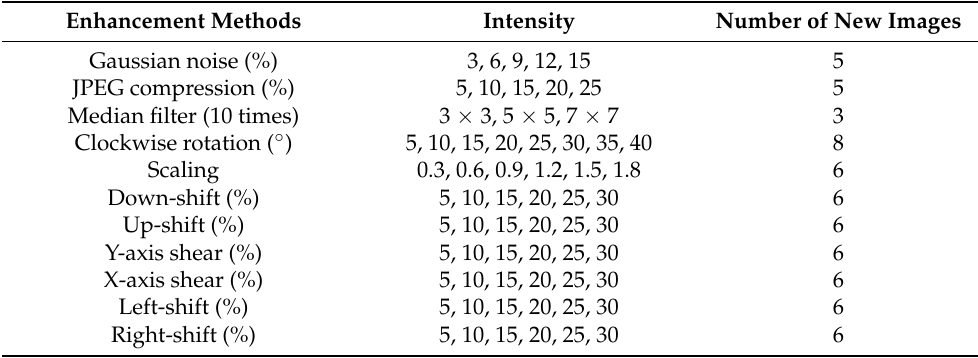
Figure 6. Watermark encryption process.